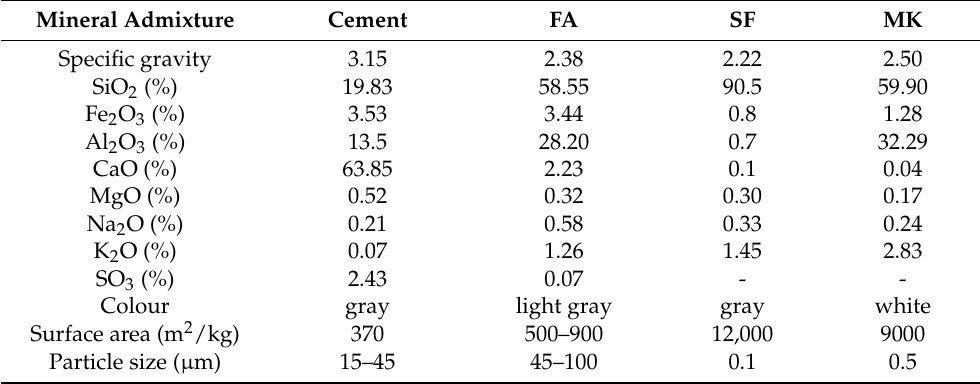
Table 1. Chemical characteristics of cement, FA, SF, and